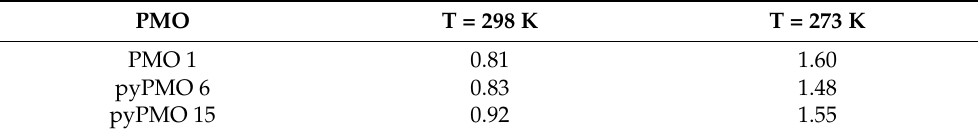
Table 2. CO 2 adsorption capacity (expressed as mmol · g − 1 ) at 10 5 Pa for the BTEE/pyridine PMO NPs.